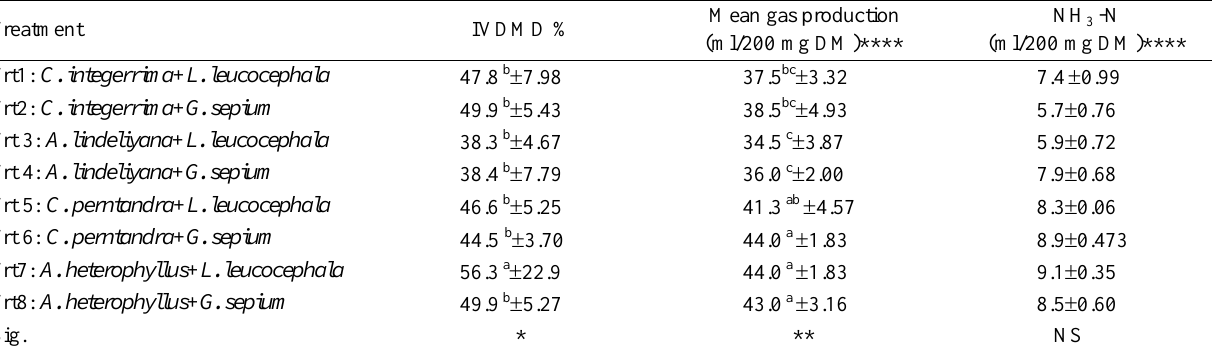
Table 5. In vitro gas production (IVGP), ammonia production (%) and dry matter degradability (IVDMD %) of forage combinations Treatment